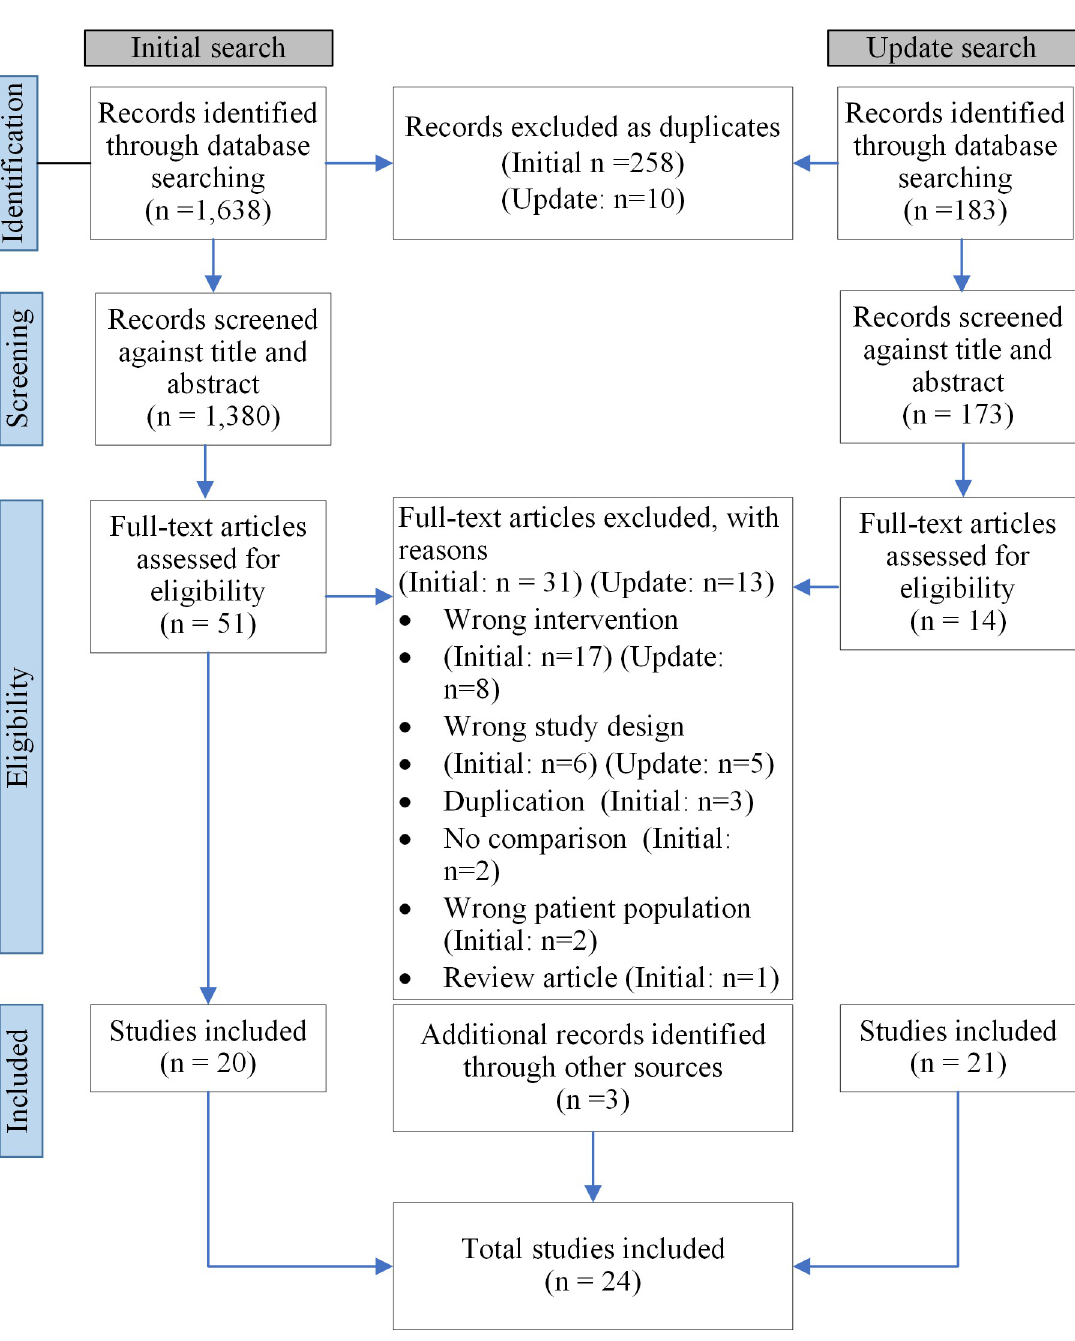
with dementia [27, 28, 31, 34], three about people with musculoskeletal disorders [22, 23, 25], and two about people with intellectual disabilities [37, 38]. There was only one study each about stroke [26], cerebral palsy [29], multiple sclerosis [30], vision loss [39] and autism [20]. Further details can be found in S2 Table.